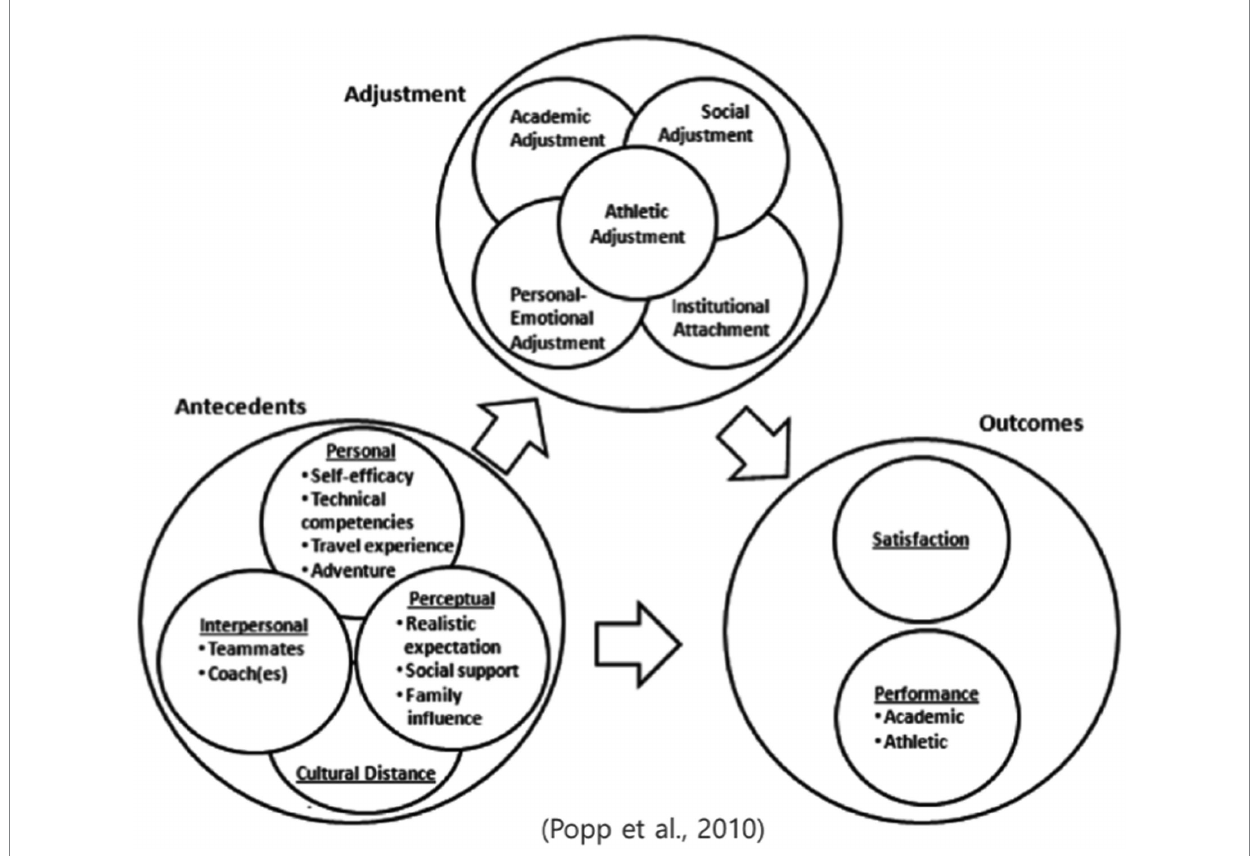
FIGURE 1 International student-athlete transition adjustment model (adapted with permission from Popp et al.,